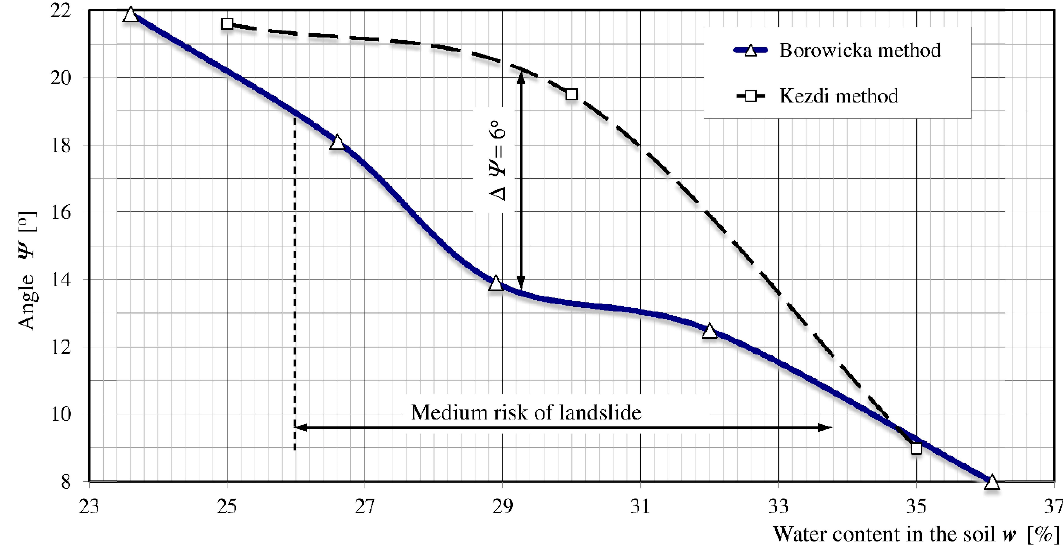
Figure 12. The inclination angle Ψ for the Borowicka and Kezdi methods at different water contents in TS forming the contact layer.